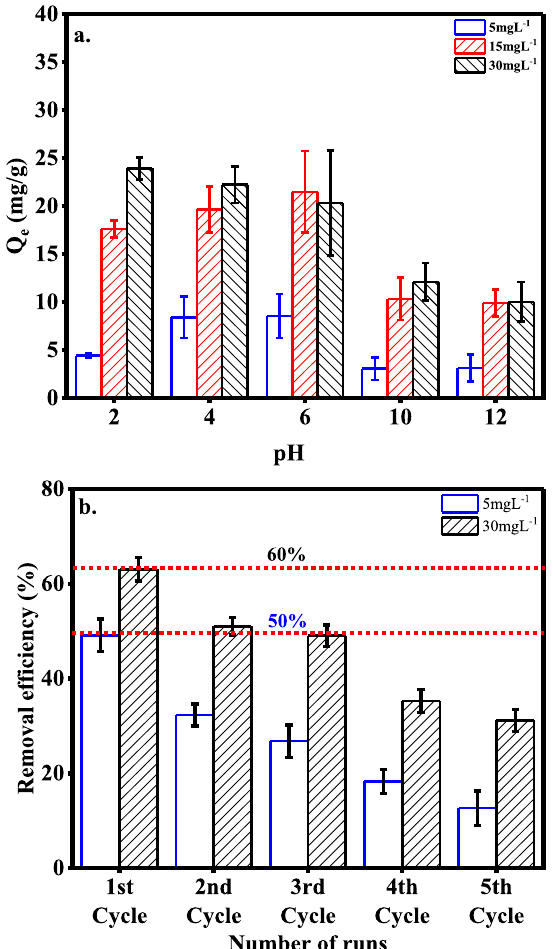
Fig. 5 a Effect of pH on adsorption. b Regeneration adsorption performance of